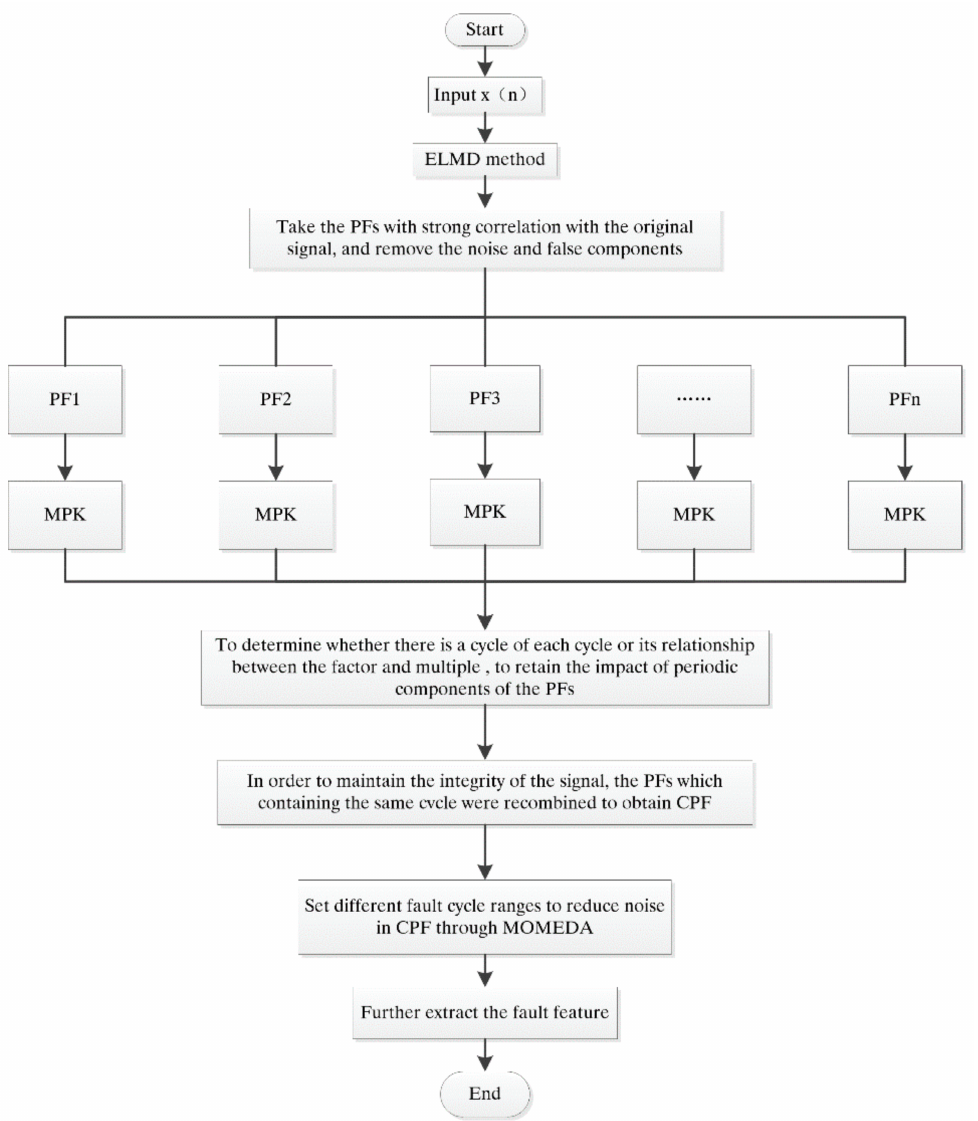
Figure 6. CPF-MOMEDA fault feature extraction flow